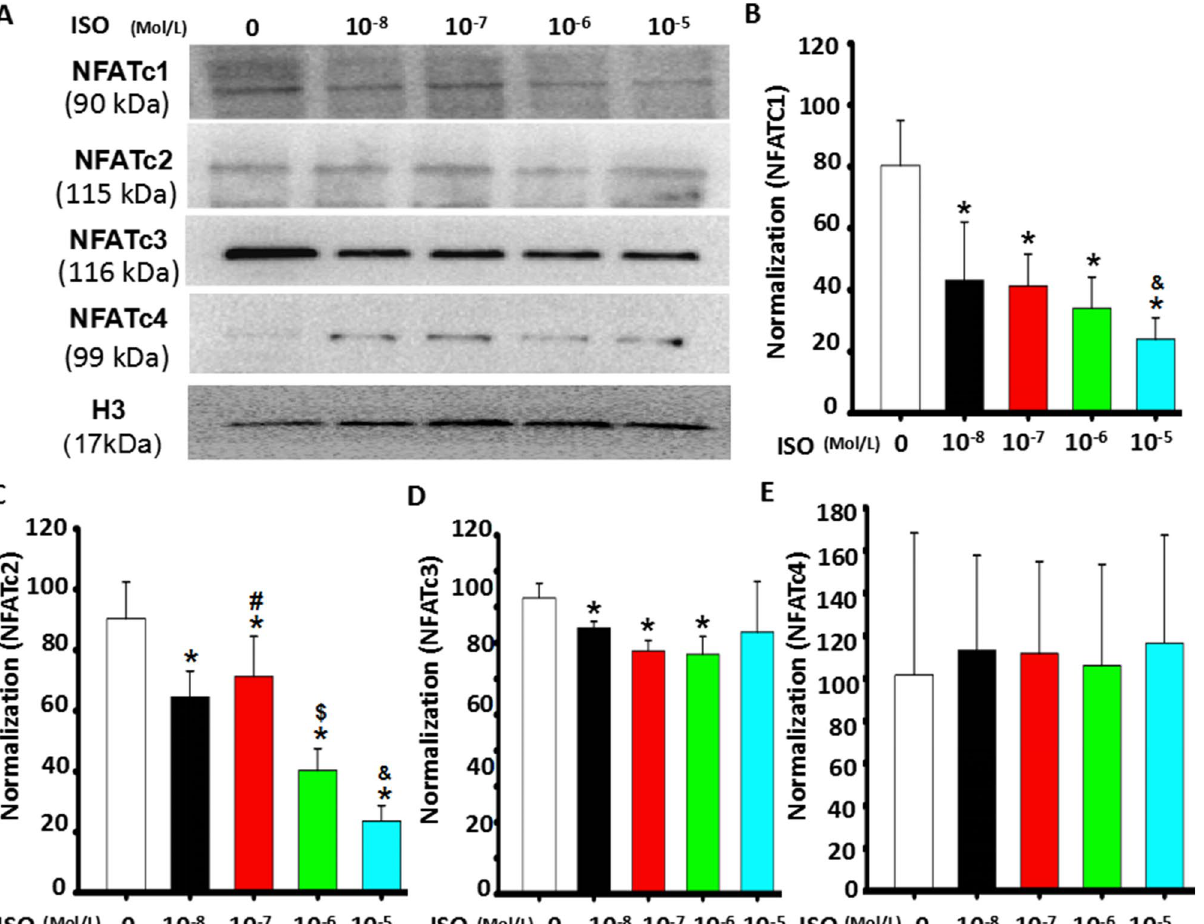
Figure 3. Continuous ISO stimulation dose-dependently altered NFATc1 and NFATc2 signaling. ( A ) Continuous ISO stimulation dose-dependently reduced nuclear levels of NFATc1 and NFATc2 while slightly increasing nuclear NFATc4 levels, as determined by western blot, five days after myoblast differentiation following stimulation with ISO delivered with a continuous single dose. ( B – E ) Semi-quantitative assay from Fig. 3A. n = 3, *P < 0.05 versus Ctrl; # P < 0.05 versus 10 −8 M ISO; $ P < 0.05 versus 10 −8 M ISO or 10 −7 M ISO.